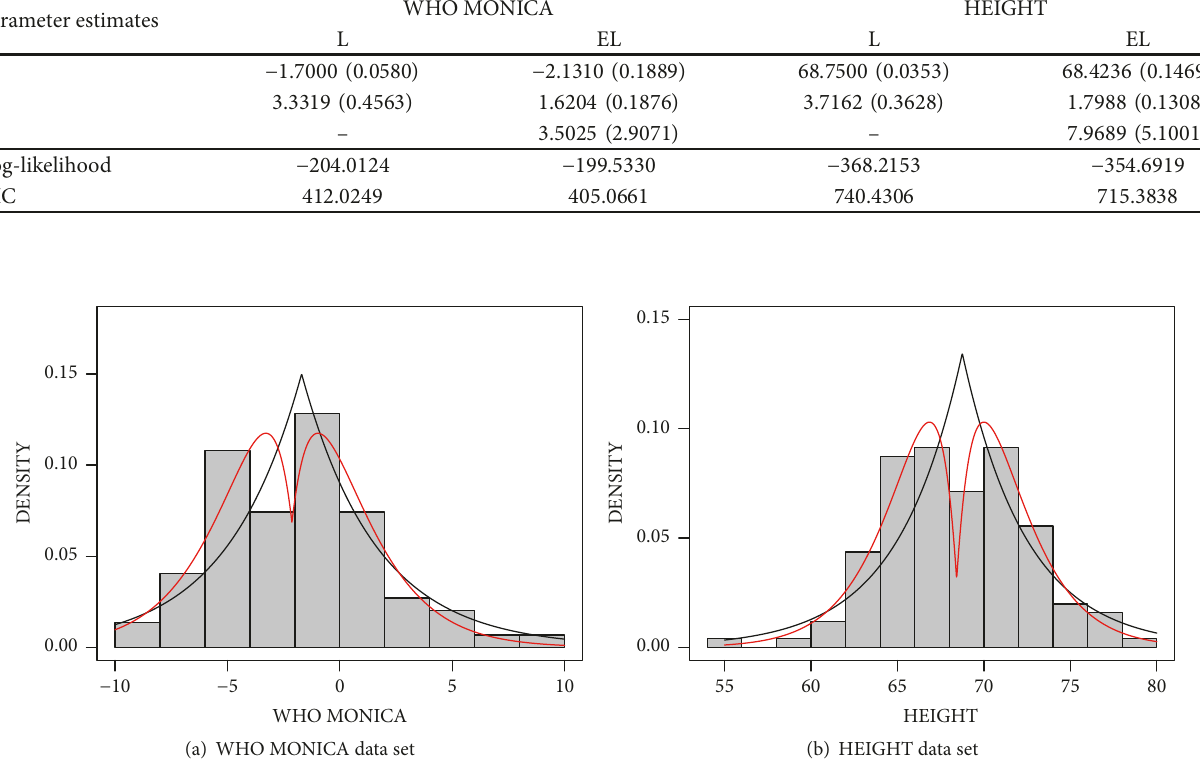
Figure 2: Histograms and the fitted curves. Extended Laplace distribution (red line) and Laplace distribution (black